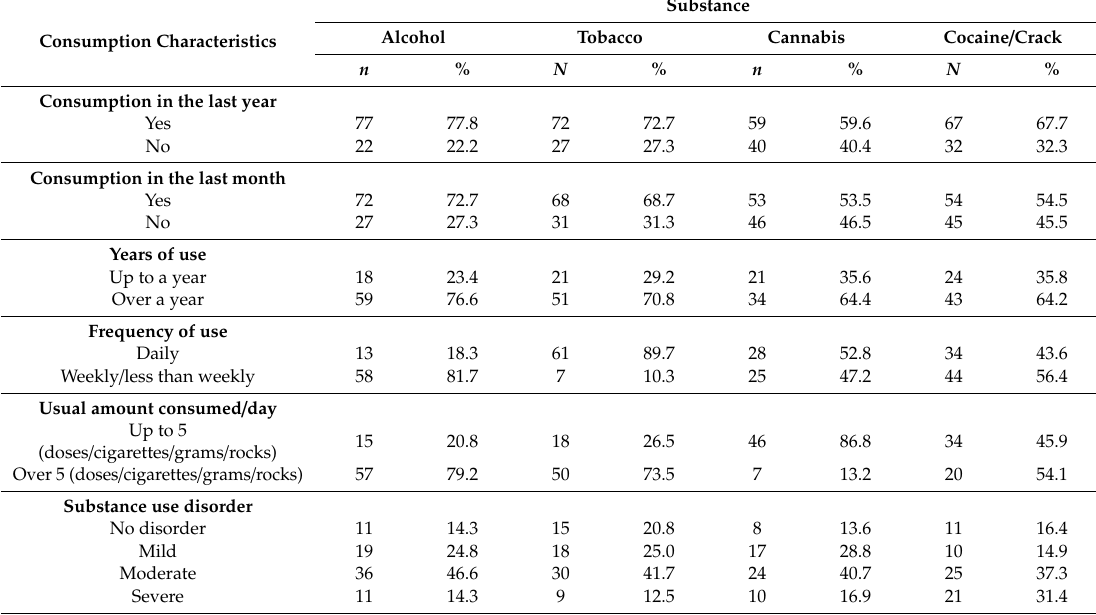
Table 2. Substance consumption characteristics among the